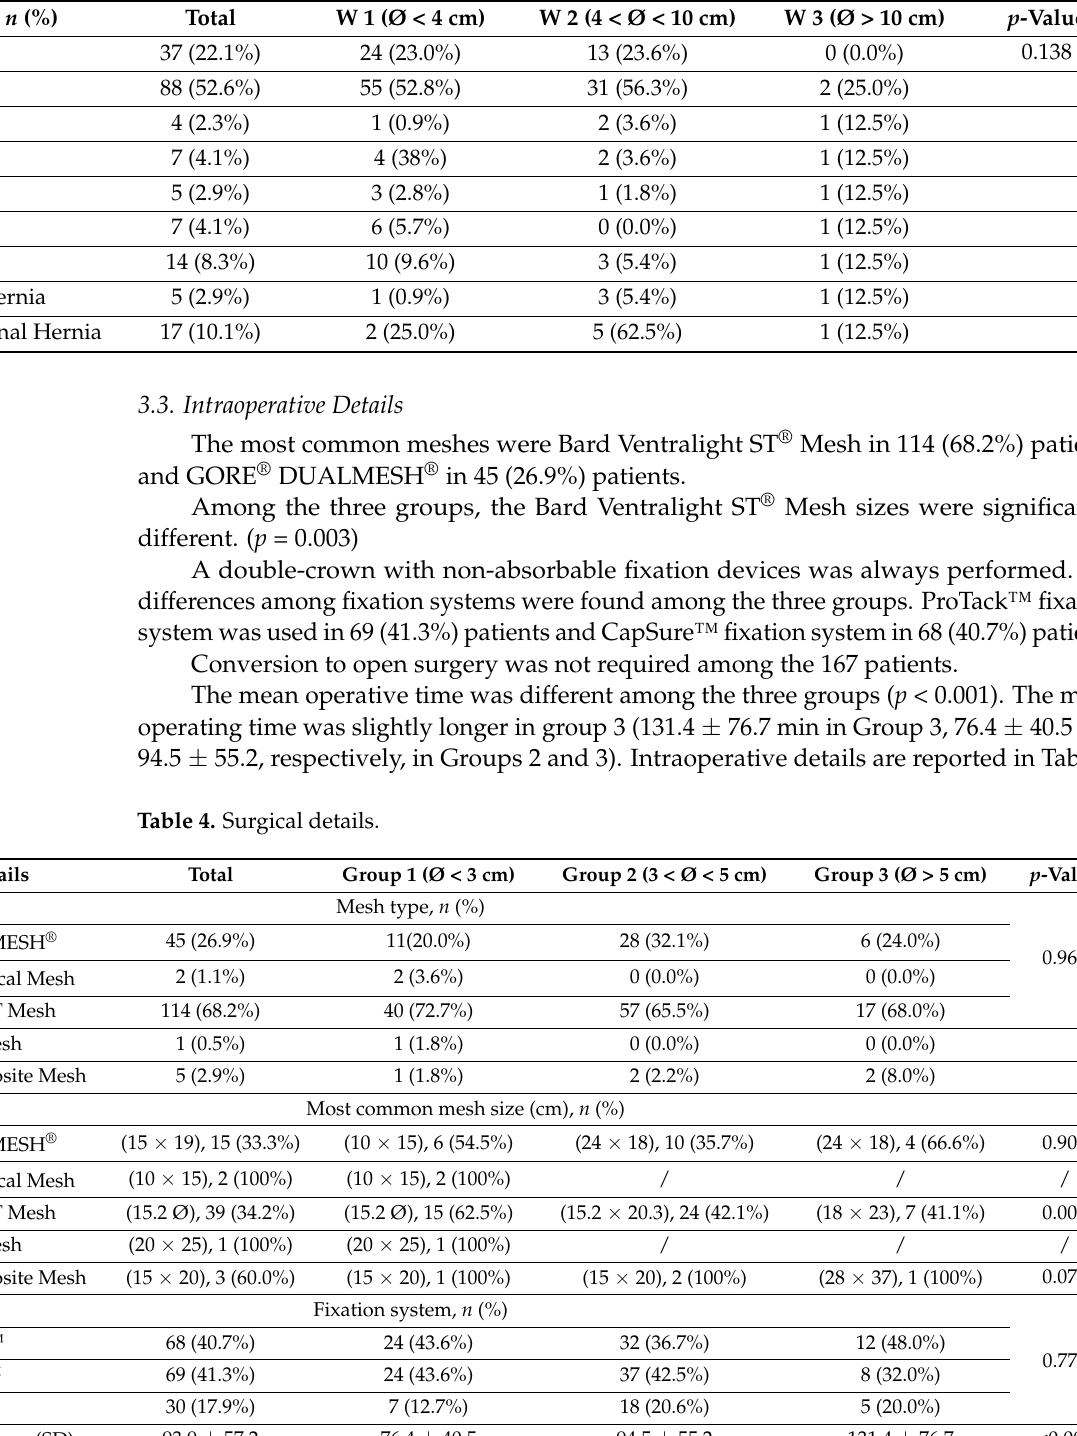
Table 3. EHS classification of